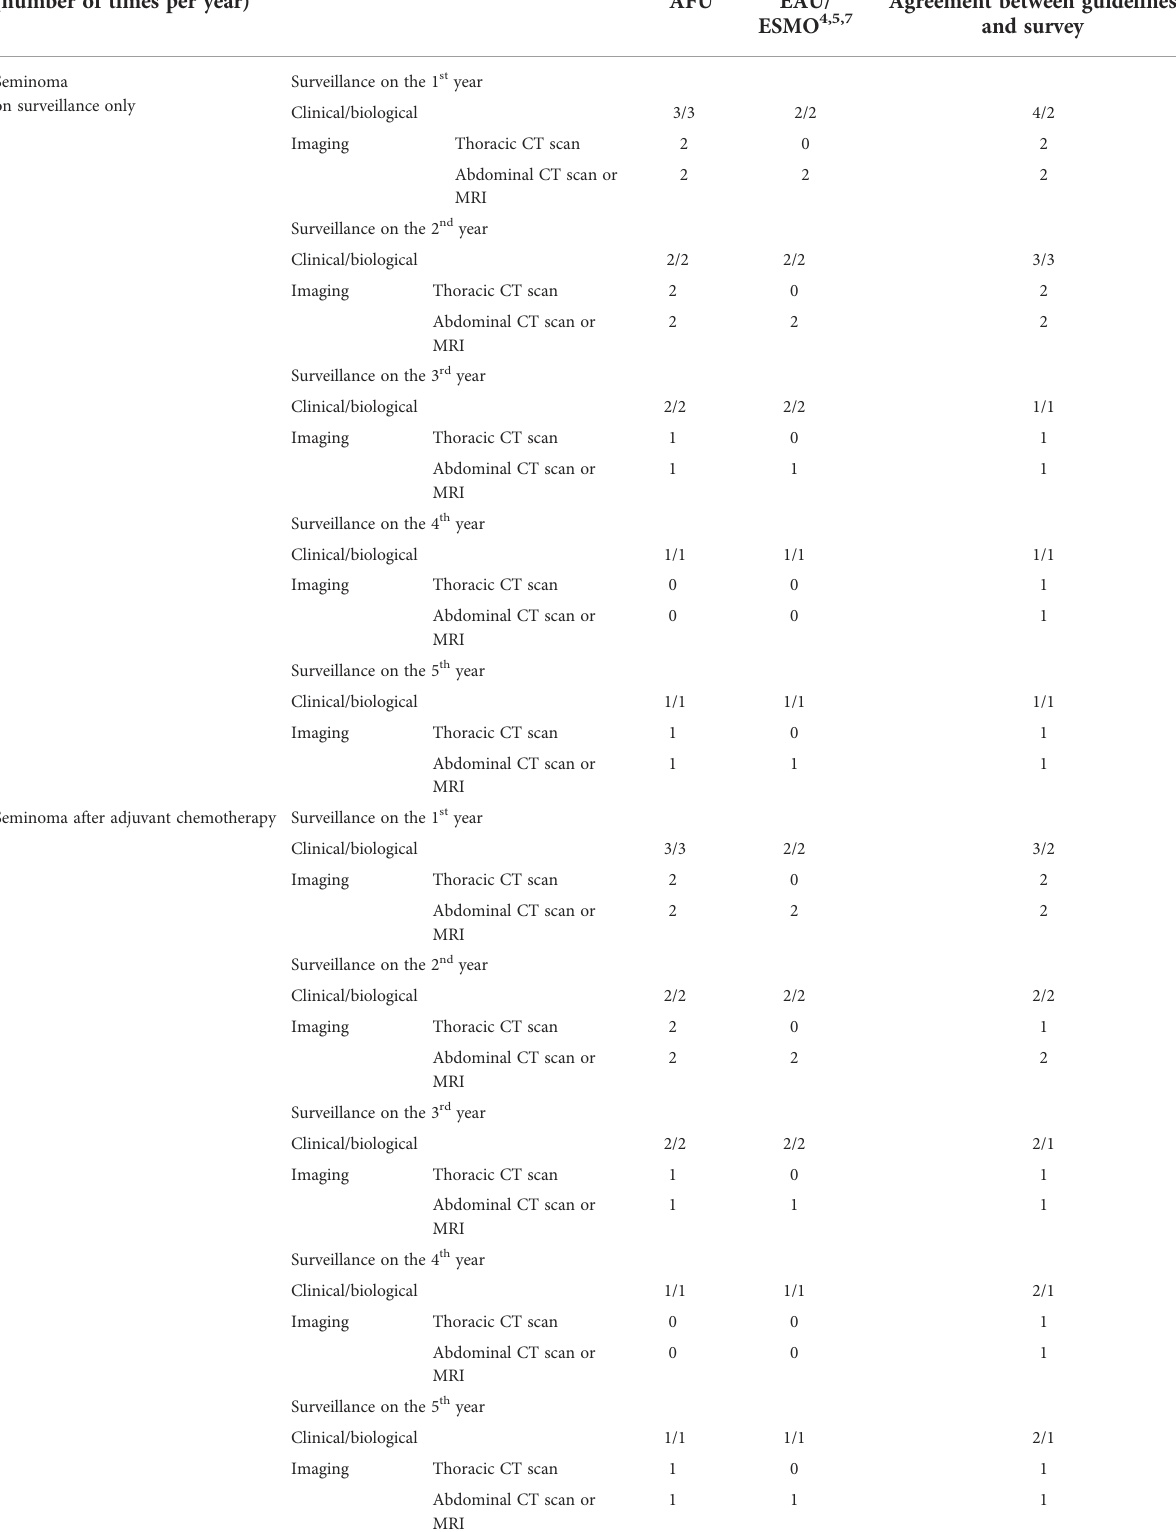
TABLE 2 Results of survey for seminoma comparing to academic societies guidelines. (number of times per